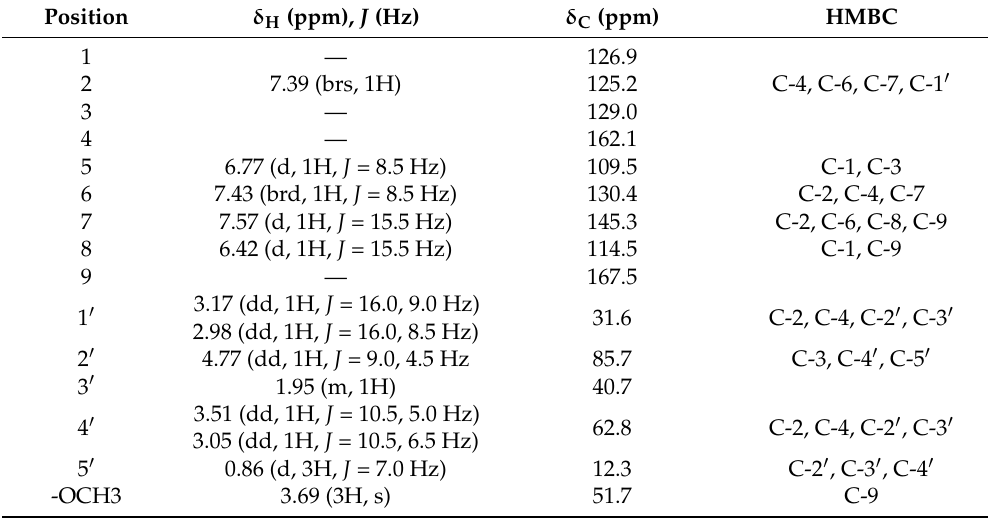
Table 1. 1 H and 13 C-NMR data (500 and 125 MHz, resp.; d 6 -DMSO) of integrinol ( 4